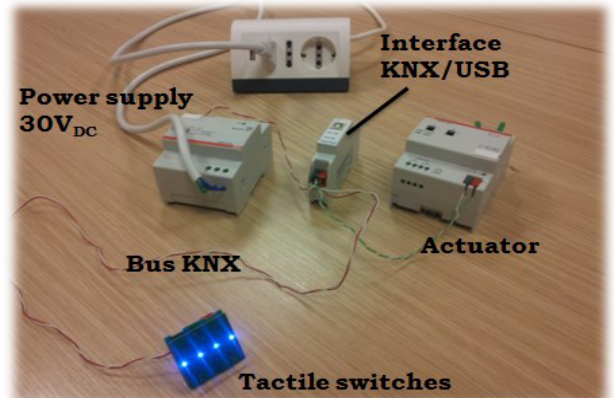
Fig. 13. Final demonstration system.